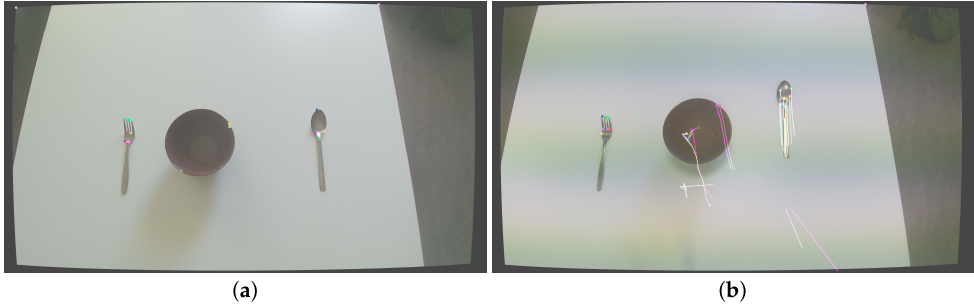
Figure 7. Sparse Optical Flow with Lucas–Kanade: ( a ) Shi–Tomasi features [34] to track, ( b ) Optical Flow with colored curves.